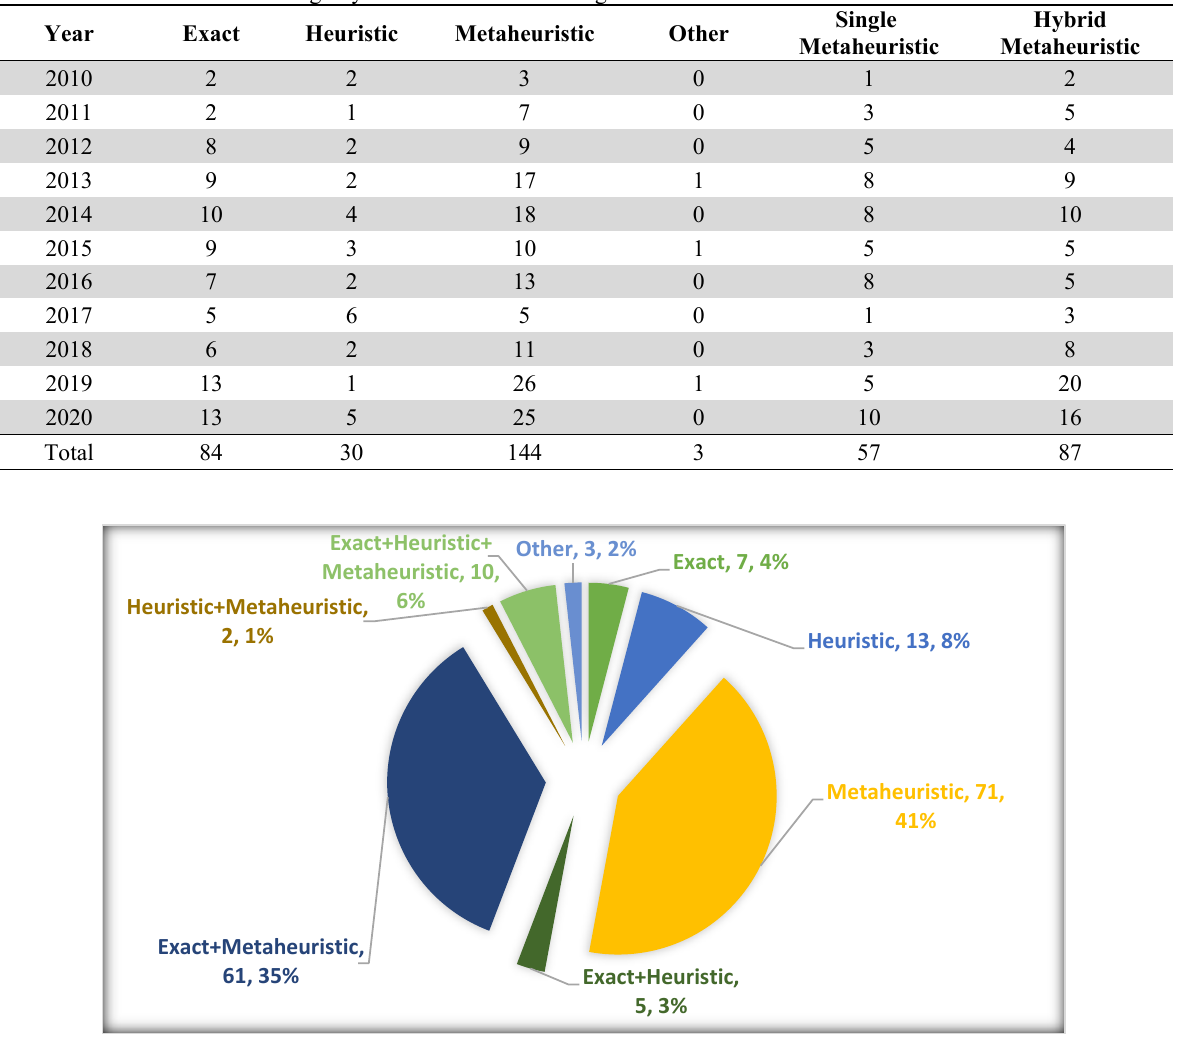
Fig. 15. Percentage distribution of HFS articles according to solution algorithms